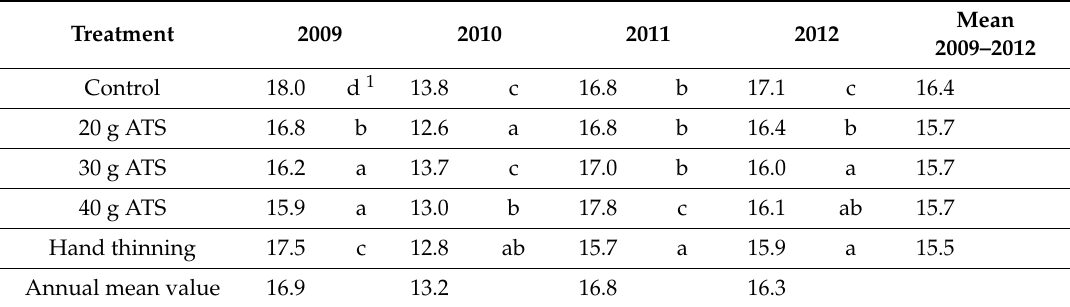
Figure 9. The effect of thinning on the colour of ‘Regina’ sweet cherry fruit in 2009, 2010, 2011 and 2012. 1 One-way analyses of variance separate for each colour coordinate; data in bars filled with the Table 5. The e ff ect of thinning on the hue value (h ◦ ) of ‘Regina’ sweet cherry fruit—mean values for 2009–2012.